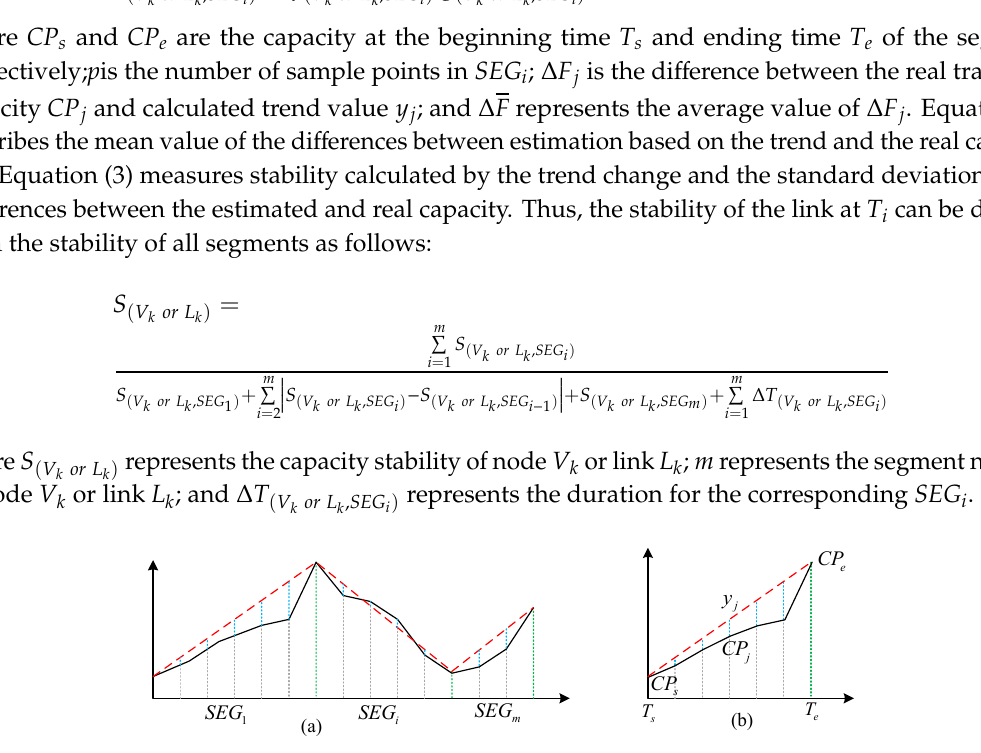
Figure 3. Variation in the capacity of a node or link. The dashed red line indicates the trend in capacity, the black line indicates the real capacity, and the dashed blue line represents the differences. (a) Segments division and (b) difference calculation for one segment).